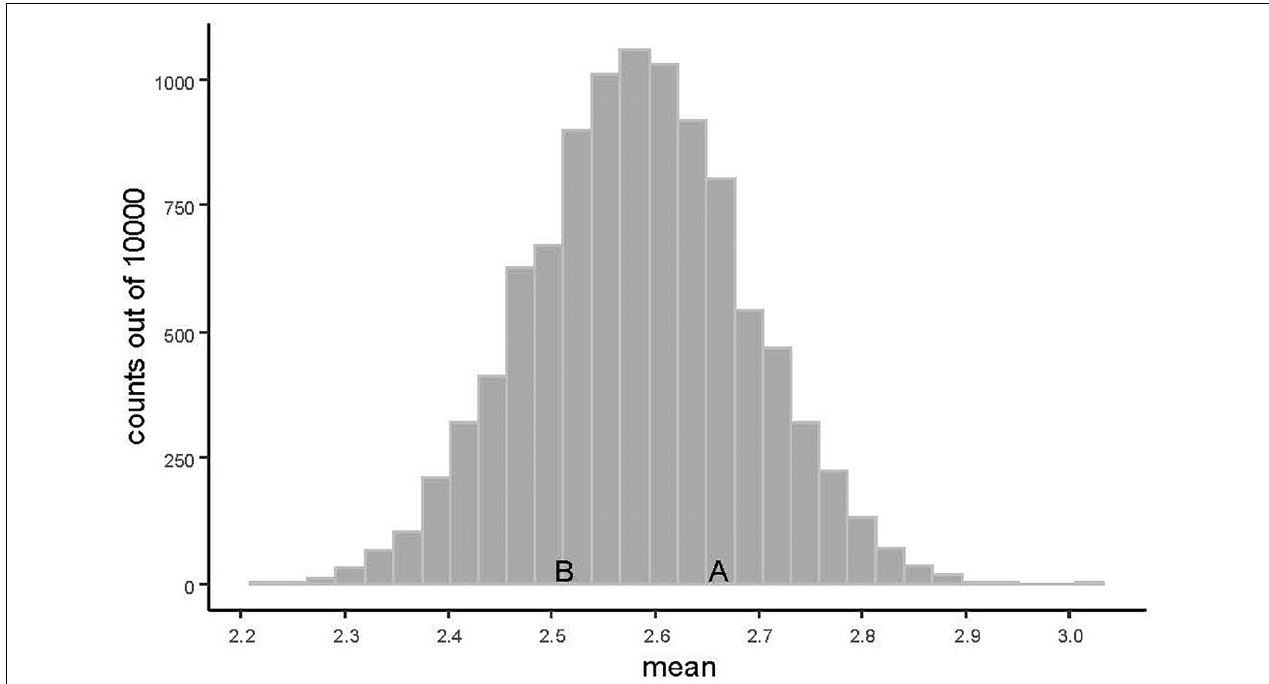
FIGURE 5 | The distribution is based on 10,000 simulations of the mean value of 25 randomly chosen numbers from the values of visual plant performance. The letters correspond to the mean values for the graphical designs: light-dark (A) and complementary (B).